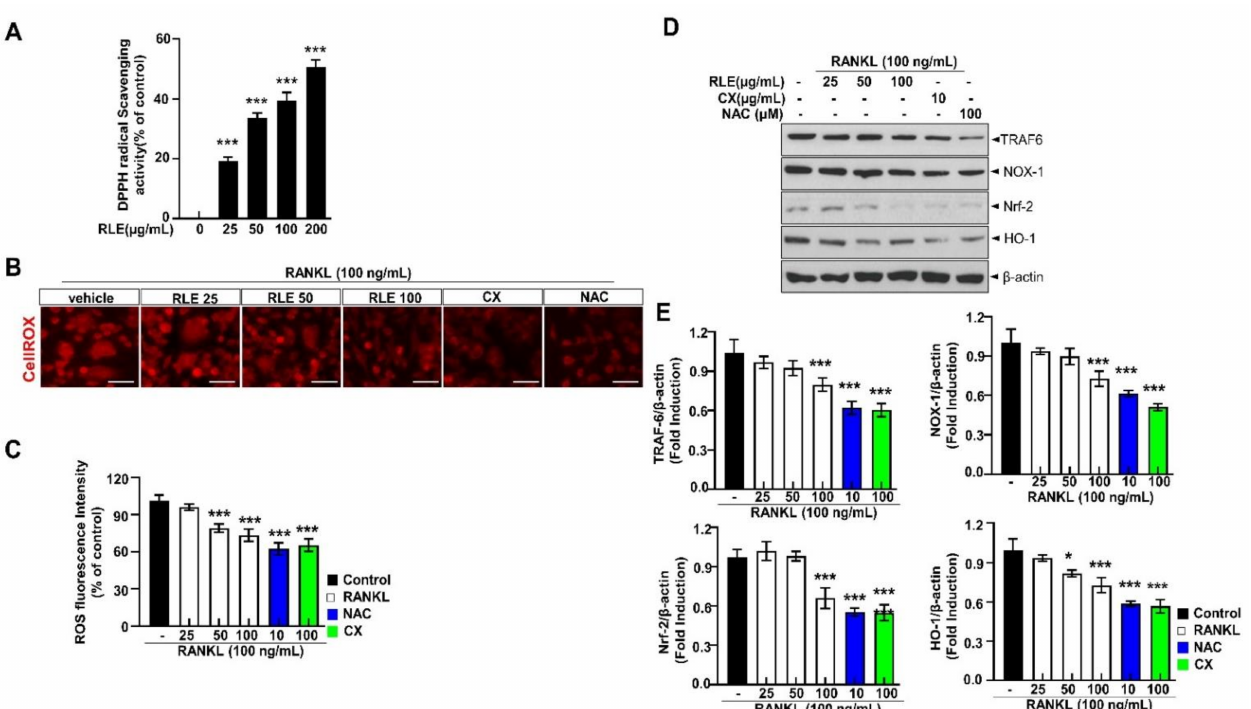
Figure 8. RLE reduces RANKL-induced ROS and its associated signalings during osteoclastogen- esis. ( A ) DPPH scavenging activity of RLE. ( B ) Detection of ROS and RANKL-induced osteoclast differentiation in vitro, respectively (scale bar = 100 µ m). ( C ) Quantitative analysis of CellROX ® Red fluorescence intensity. ( D ) NOX-1 expression. ( E ) Immunoblotting using antibodies against TRAF-6, NOX-1, Nrf-2, HO-1, and β -actin. Values are presented as mean ± SEM. ( n = 3, * p < 0.05, *** p < 0.001 vs. RANKL) NOX-1, NADPH oxidase 1; CX, canthaxanthin; NAC, N-acetyl